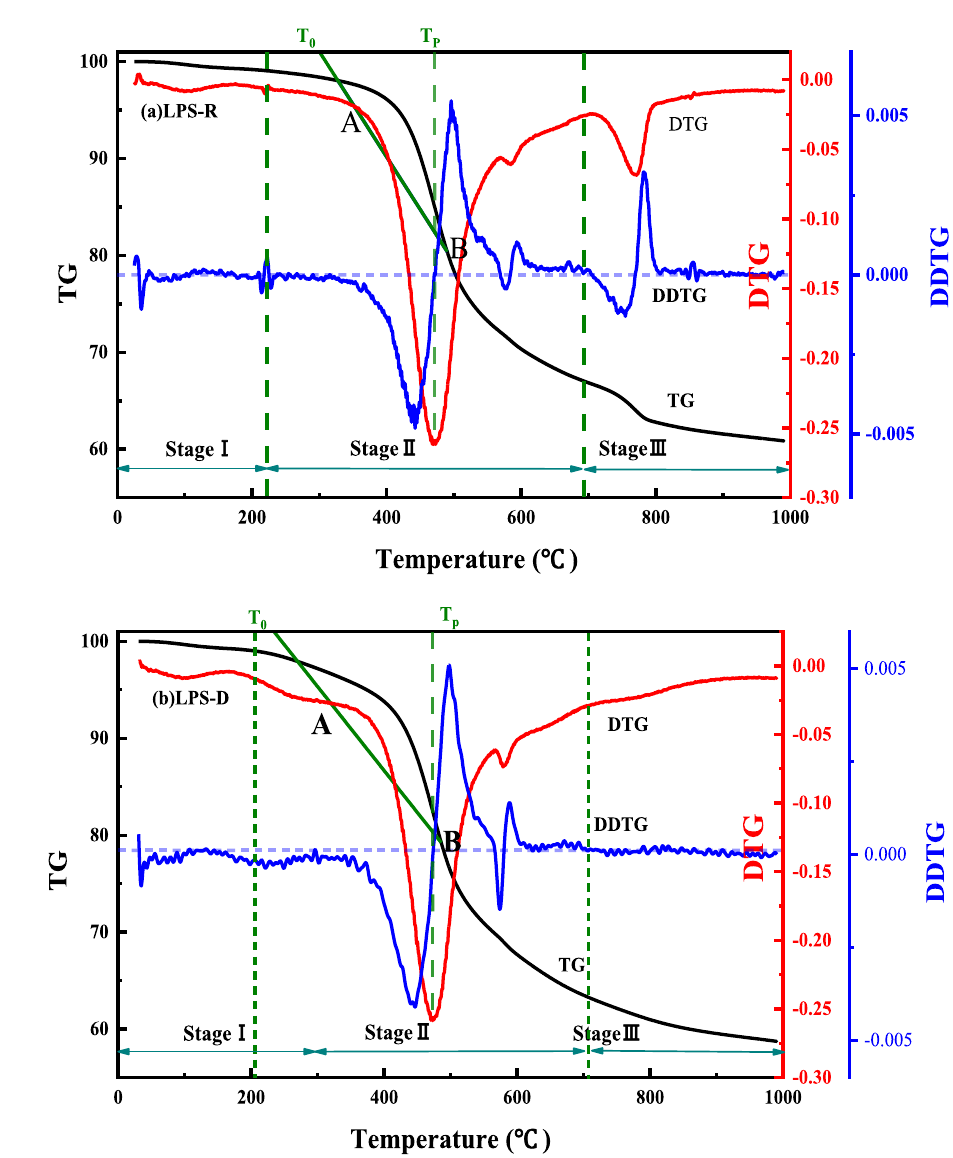
Fig. 5 TG, DTG and DDTG curves of LPS-R and LPS-D at heating rate of 40